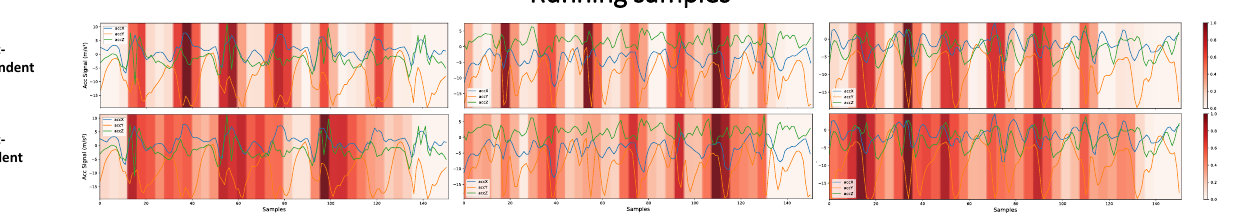
Figure 15. Higher-importance segments for decision making in the CNN2 architecture, for HAR with SI and HAR with SD, considering samples of the Running class with different subjects. To obtain the heatmaps, no threshold was considered in the grad-CAM result in order to make more transparent the smaller, but significant, importance zones that the SD strategy takes into account.